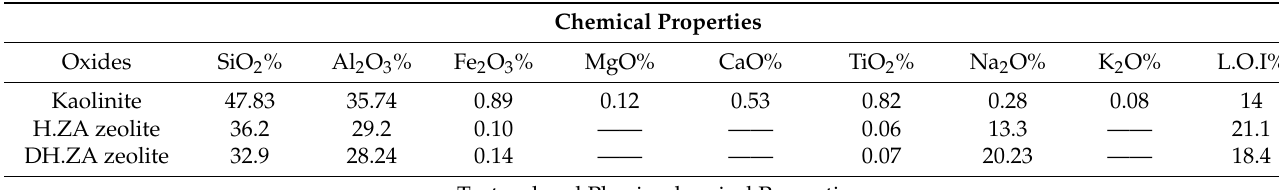
Table 1. The chemical composition and microstructural and physicochemical properties of kaolinite, H.ZA and